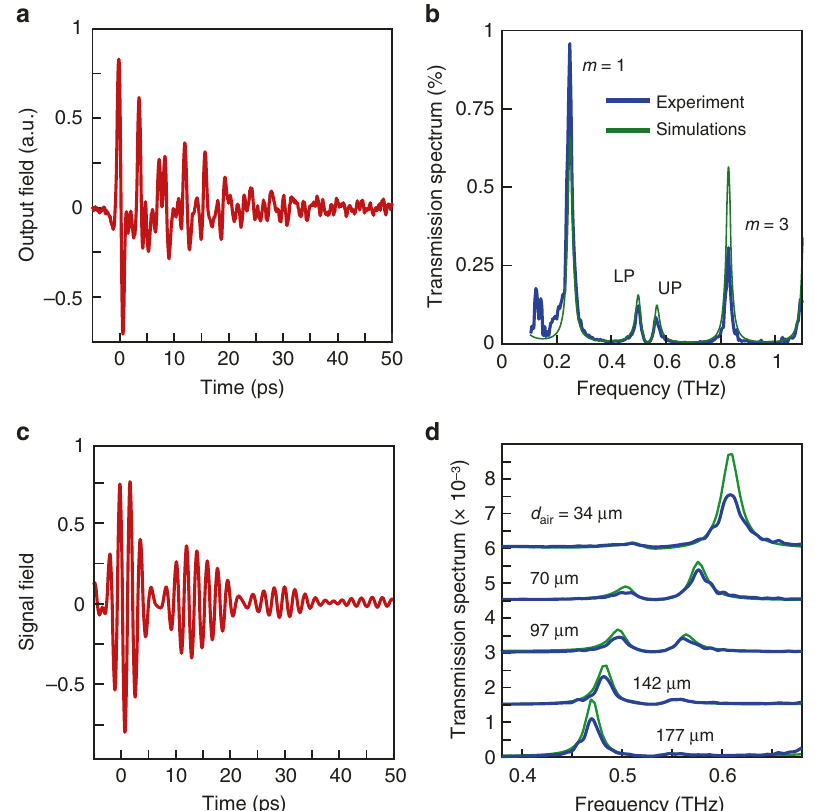
Fig. 4 Strong coupling of collective THz vibrations in α -lactose. a Measured time-domain output signal from the cavity with the α -lactose pellet, with its length chosen such that the second cavity resonance ( m = 2) is at 0.53 THz. b Transmission spectrum of the cavity with α -lactose with a total cavity length of 350 μ m, obtained from the experimentally measured time domain signal in Fig. 4a (blue line) and by T-matrix calculations (green line). The strong coupling between the collective vibrations and the cavity results in a spectral splitting that indicates the formation of hybrid vibro-polariton states. c Spectrally fi ltered output signal from the cavity, showing the Rabi-oscillations of the coupled system in the time-domain. d Selected cavity transmission spectra in the vicinity of the α -lactose absorption peak (0.53 THz), measured with different air gap thicknesses d air and α -lactose pellet thickness of d α L = 250 μ m (blue lines), compared to T-matrix calculations (green lines)